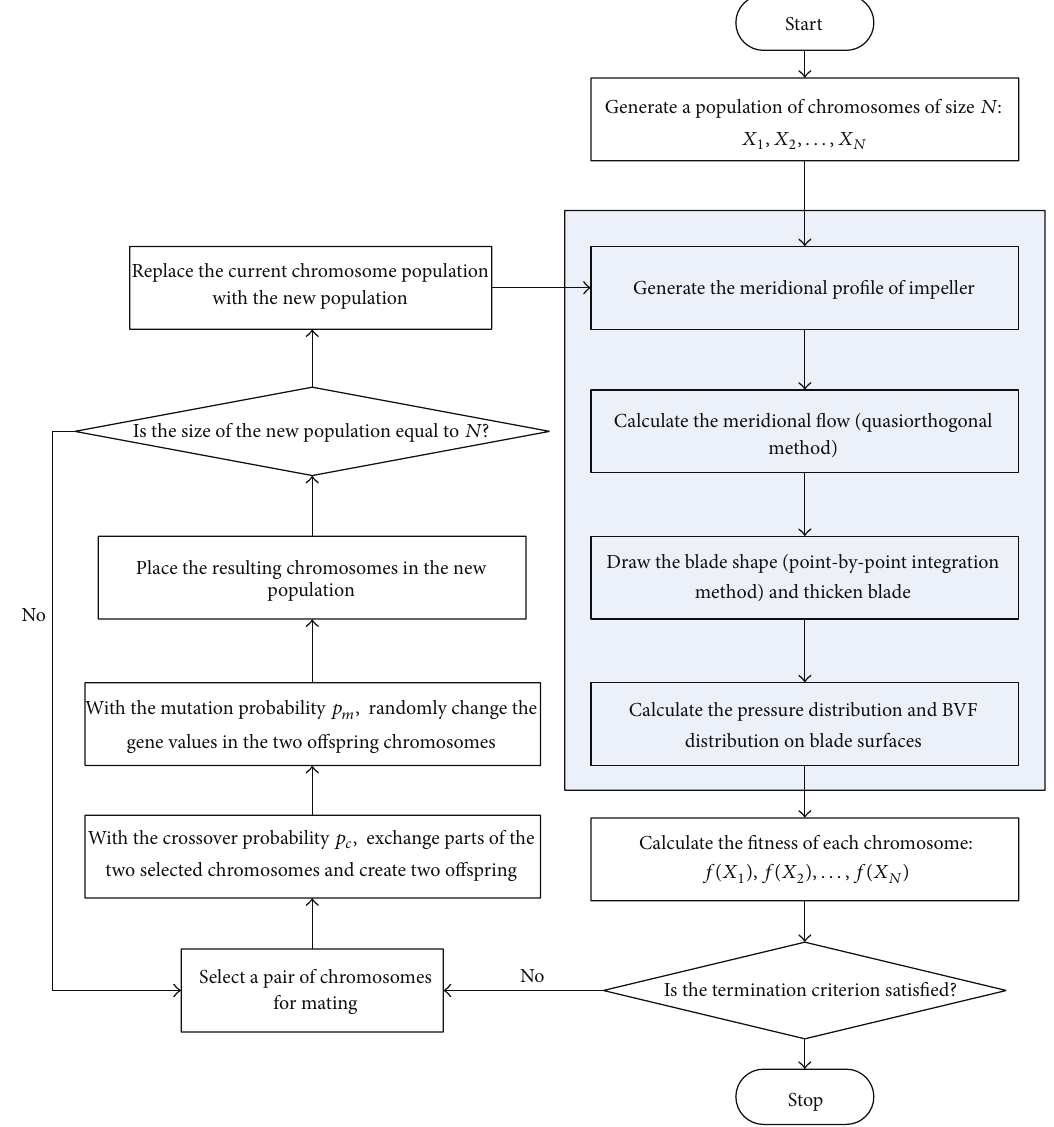
Figure 1: Flowchart of GA hydraulic